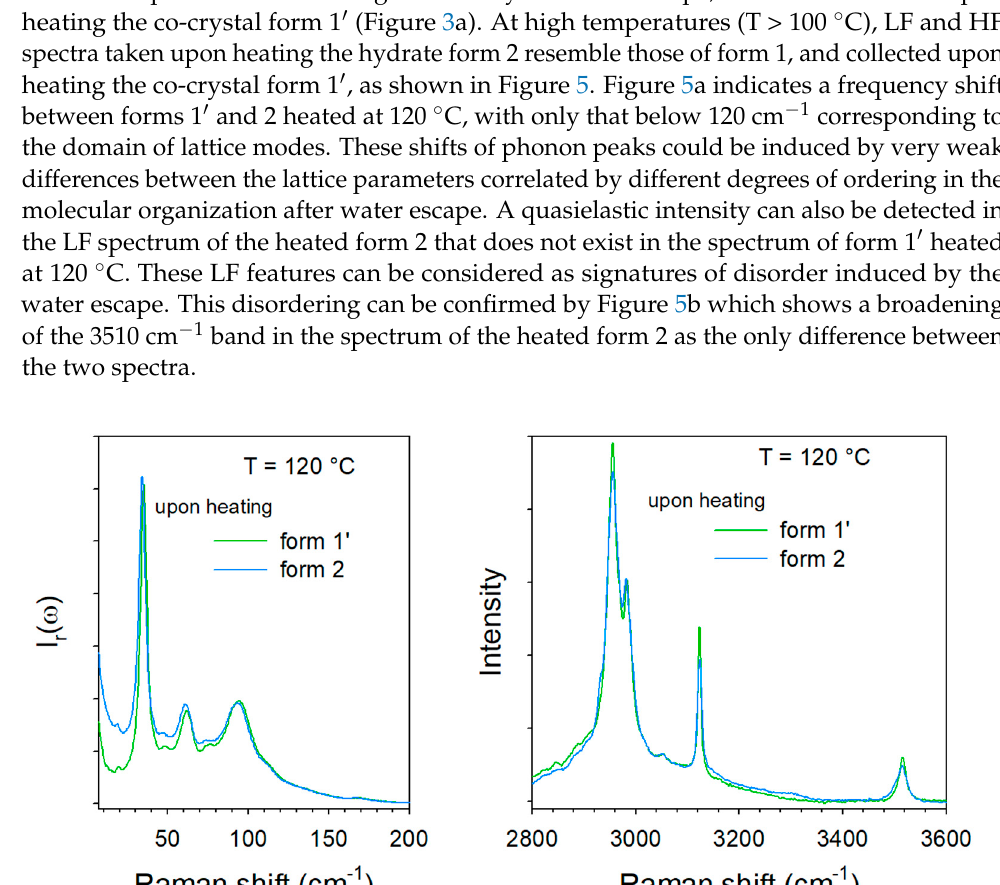
Figure 6. Data analysis of the low-frequency spectra of the co-crystal form 1 ′ and 2; ( a ) temperature dependence of the quasielastic intensity (I QES ); ( b ) temperature dependence of the position of the phonon peak located around 35 cm − 1 ; ( c ) temperature dependence of the position of the Raman band located around 66 cm − 1 . Deeper investigations in the HF region were carried out via the analyses of the fre- quency of the 3125 cm − 1 Raman band and the intensity of Raman bands at 3360 and 3510